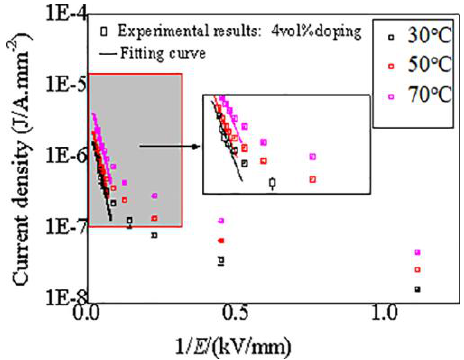
Figure 5. Fitted curves of tunneling effect in CCTO/EPDM composites at different temperatures.